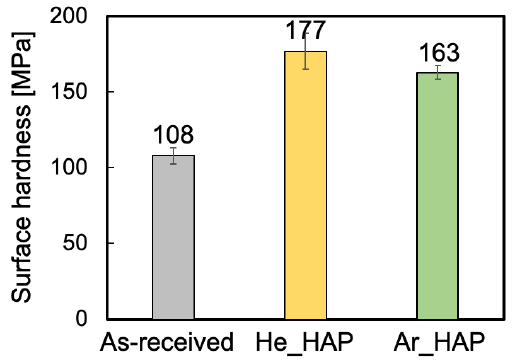
Figure 7. Surface hardness of the PTFE samples HAP-treated using He or Ar gas.